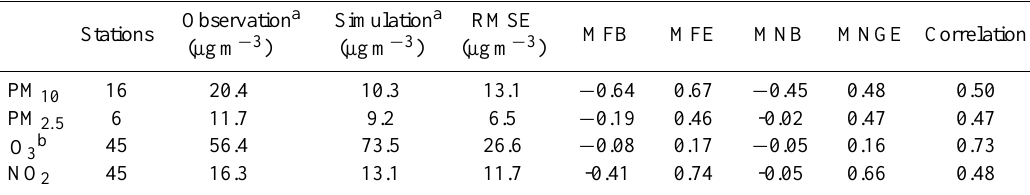
Table 2. Comparison of the modeled concentrations and observations of the BDQA monitoring network. Performance statistics were calcu- lated with hourly concentration for all